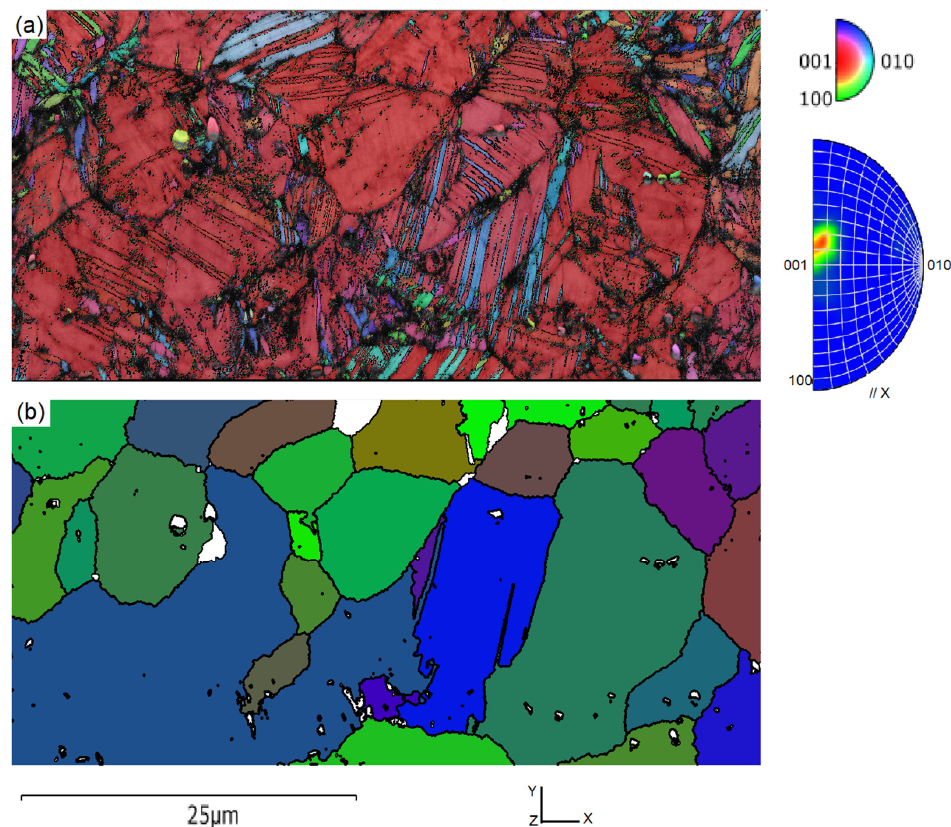
Figure 7. B19 (cid:48) martensite reorientated by bending a martensitic NiTi bar (10 mm long and 2 mm thick) at room temperature into a U-shape. ( a ) IPF-X EBSD map of the B19 (cid:48) phase. The map was acquired in the tensile part, with the tensile direction along X (horizontal direction). The initial microstructure before bending was constituted of long lenticular laths (see Figure 4b of Ref. [24]). The reddish color of the IPF-X map and the high density close to 316 in the IPF map presented on the right-hand side (Multiple of Uniform Distribution, MUD = 27) show that the B19 (cid:48) variants are reorientated under the stress. ( b ) IPF-X map of the parent B2 grains reconstructed with ARPGE.